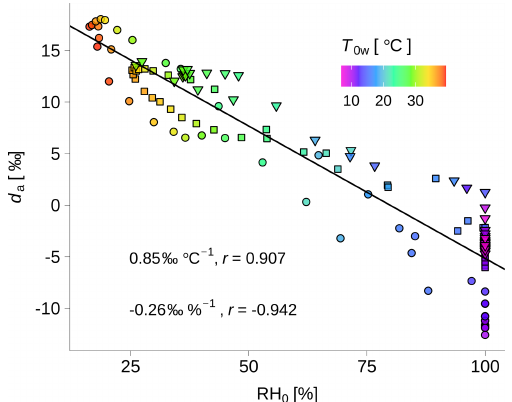
Figure 12. The orthogonal regression of deuterium excess of ambi- ent water vapor ( d a ) with surface relative humidity (RH 0 ) computed from volumetric water vapor mixing ratio ( w a ) using Eq. (3) and air temperature ( T a2m ) at 2ma.g.l. Slopes and Pearson’s r values for regressions are